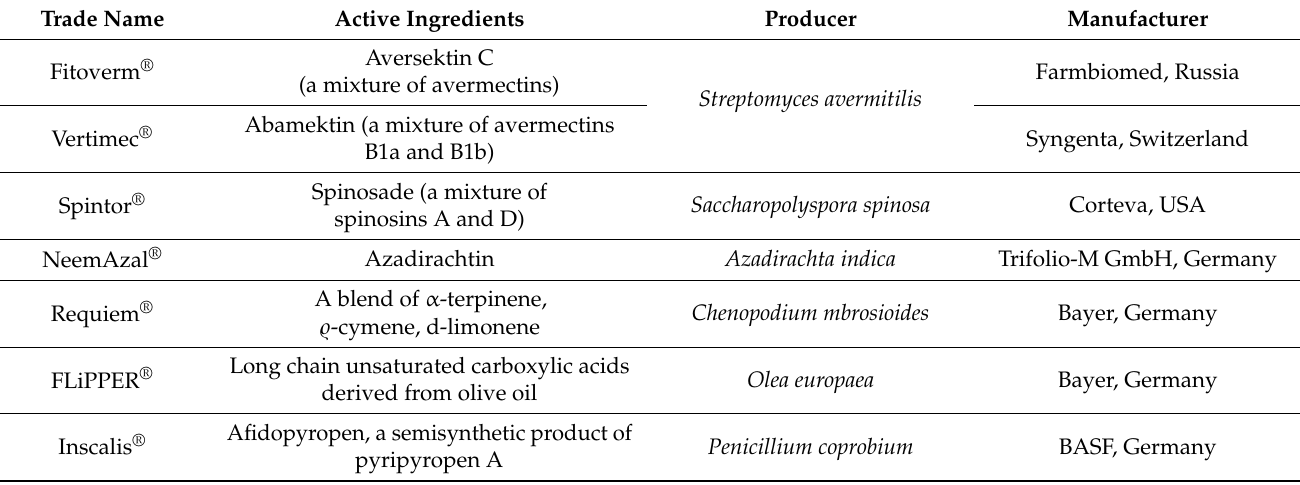
Table 2. Examples of insecticides based on natural compounds